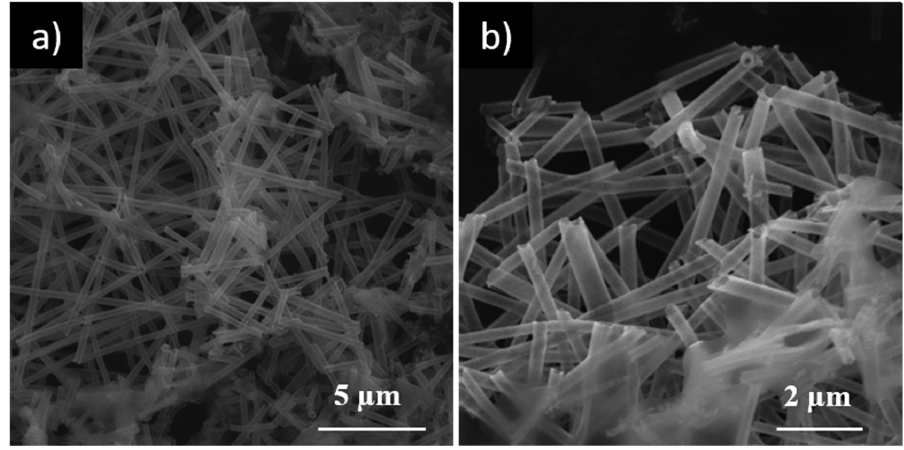
Figure 3. SEM micrographs of ZnO NT at magnifications: ( a ) 10 kx; and ( b ) 20 kx.